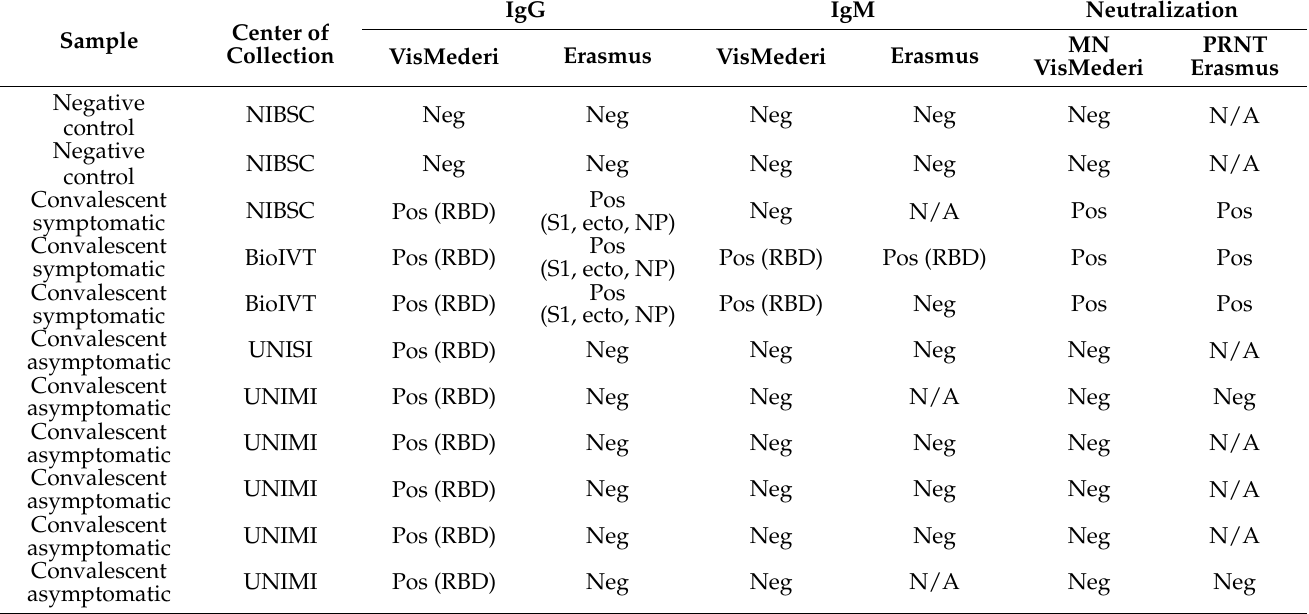
Table 2. Serological results in negative controls, convalescent symptomatic and asymptomatic COVID-19